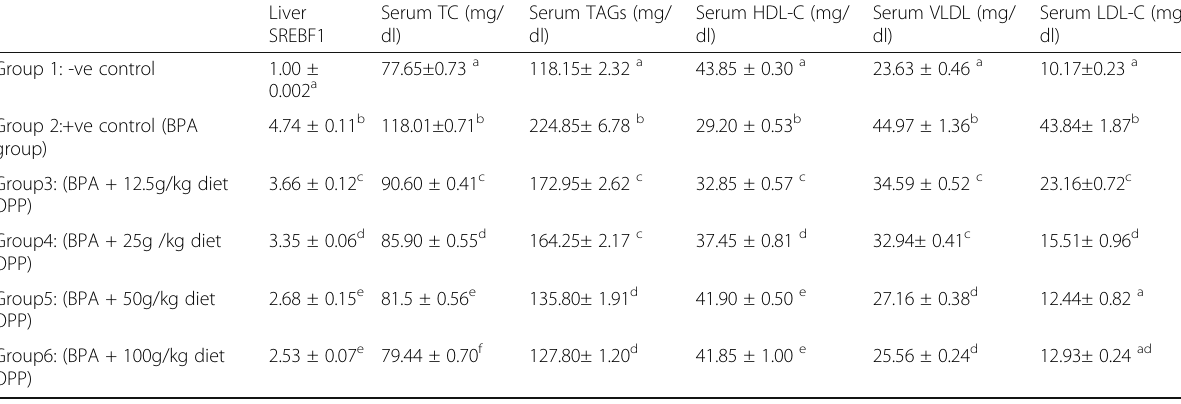
Table 1 The effect of orange peel powder on liver SREBF1 expression and serum lipid profile in BPA-treated rats